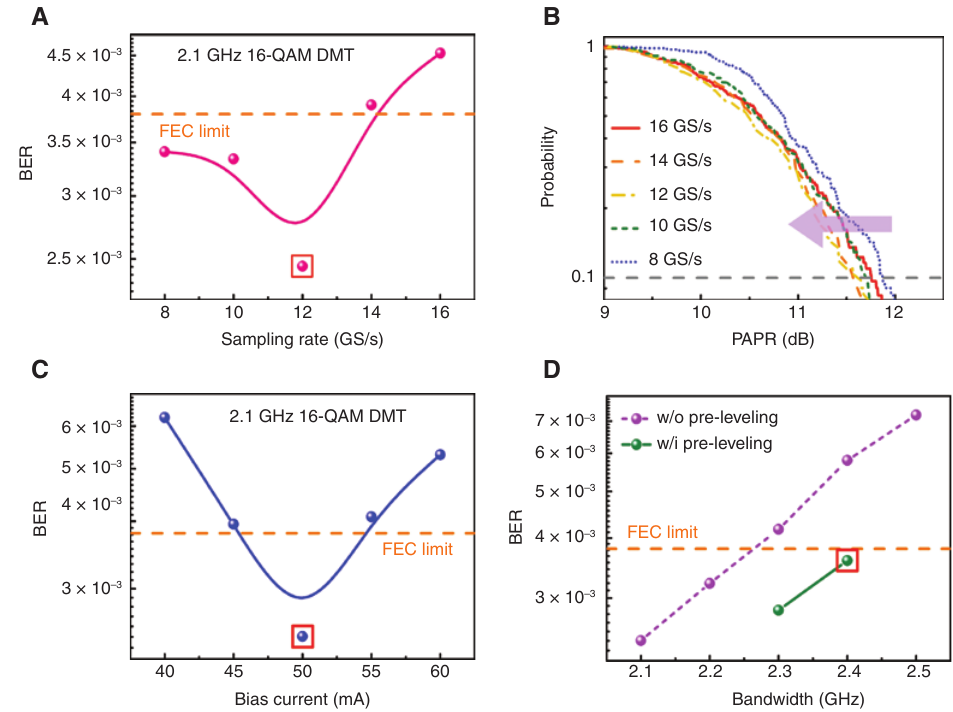
Figure 8: The white-lighting transmission performance of the VLD + dSe/ZnS core-shell-QD at different operating conditions. (A) BERs and (B) PAPRs of 2.1-GHz 16-QAM DMT data transmitted by the VLD adhered with the CdSe/ZnS core-shell-QD doped PDMS film at different sampling rates; (C) BERs of 2.1-GHz 16-QAM DMT data at different bias currents; (D) BERs of 16-QAM DMT data at different bandwidths before and after